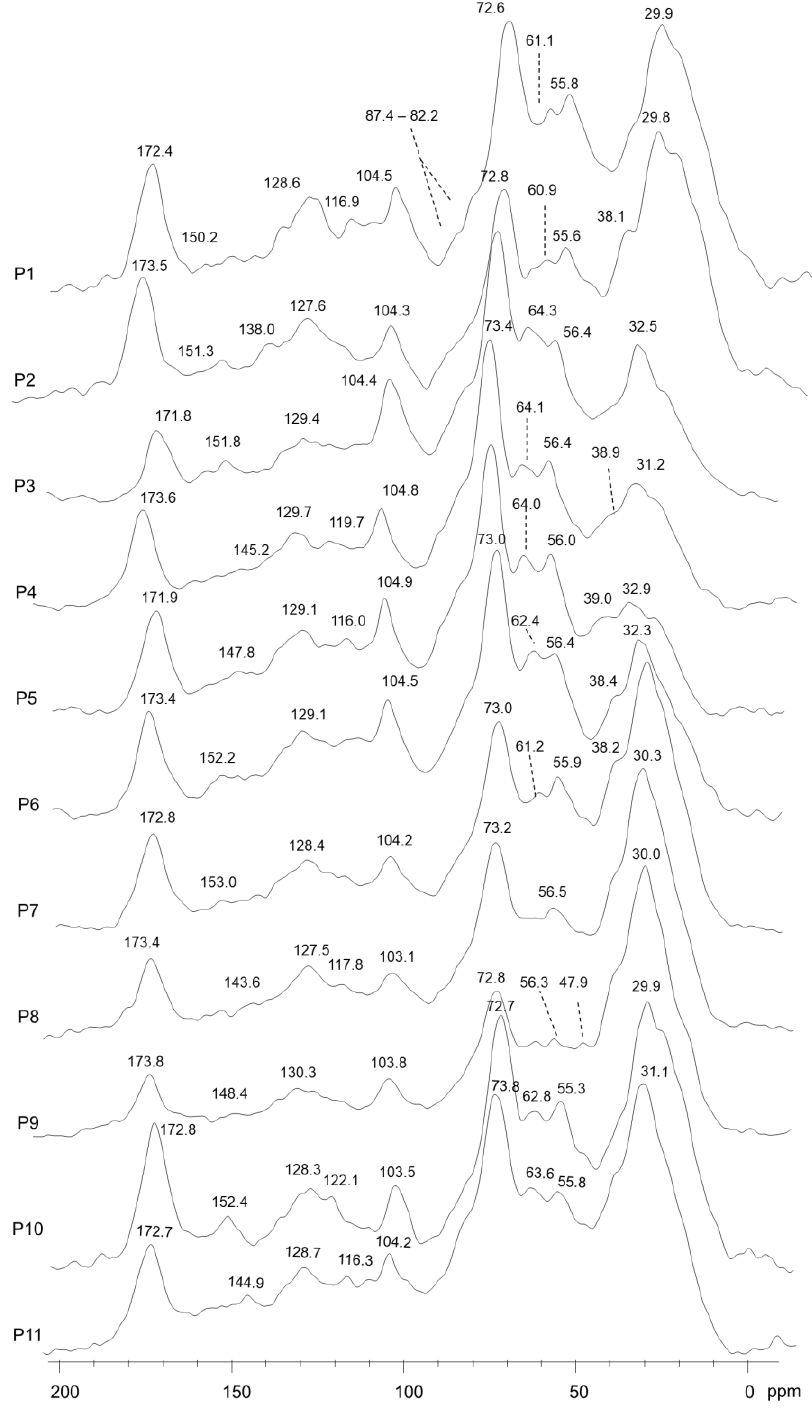
Figure 4. 13 C-CPMAS-NMR of compost samples